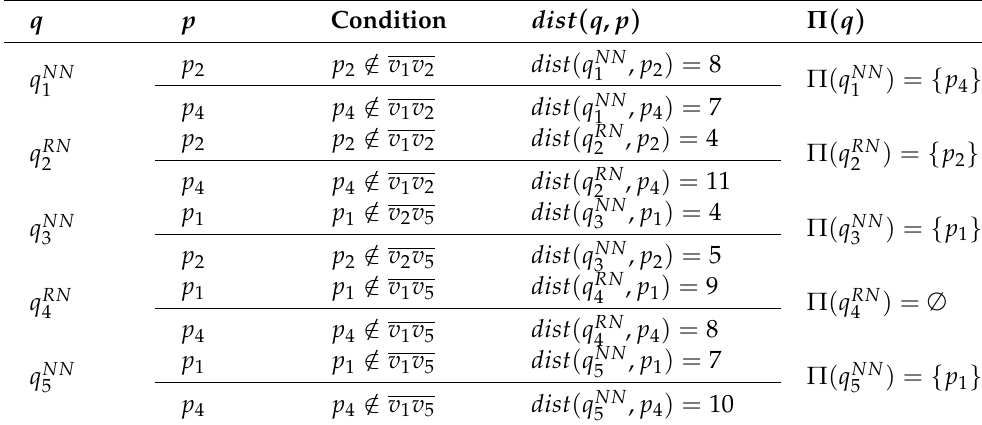
Table 4. Computation of the distances between the queries and the candidate data